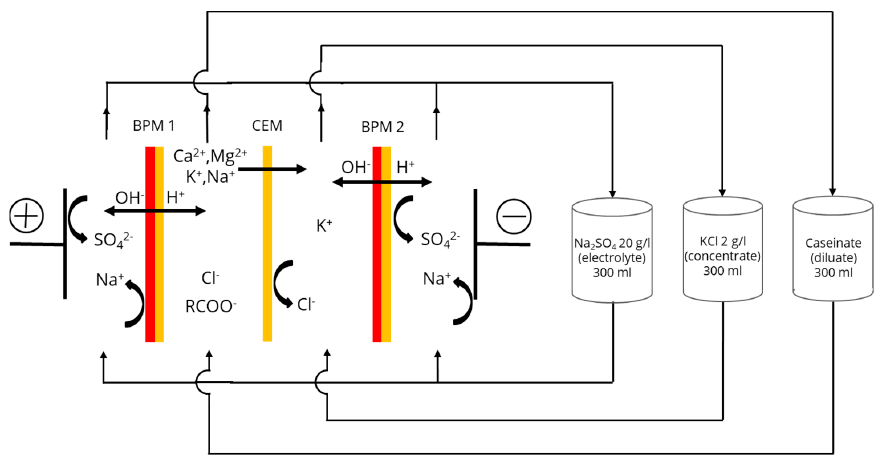
Figure 1. ED cell configuration for caseinate solution electroacidification by EDBM process.